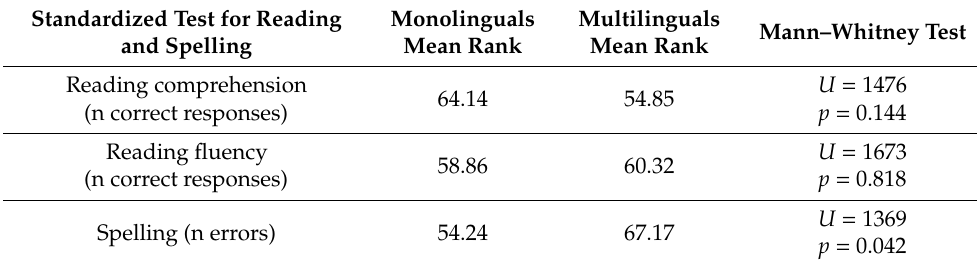
Table 3. Mean ranks for monolinguals and multilinguals for standardized tests of reading (reading